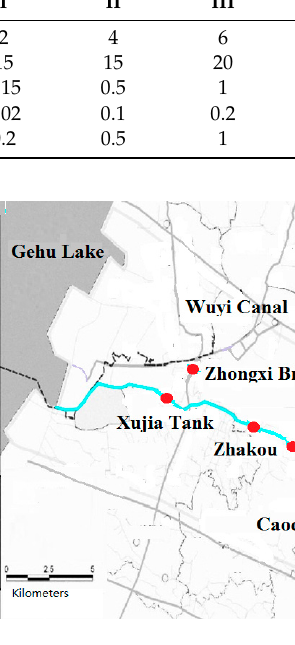
Figure 1. Map of the study area with locations of water quality monitoring stations.